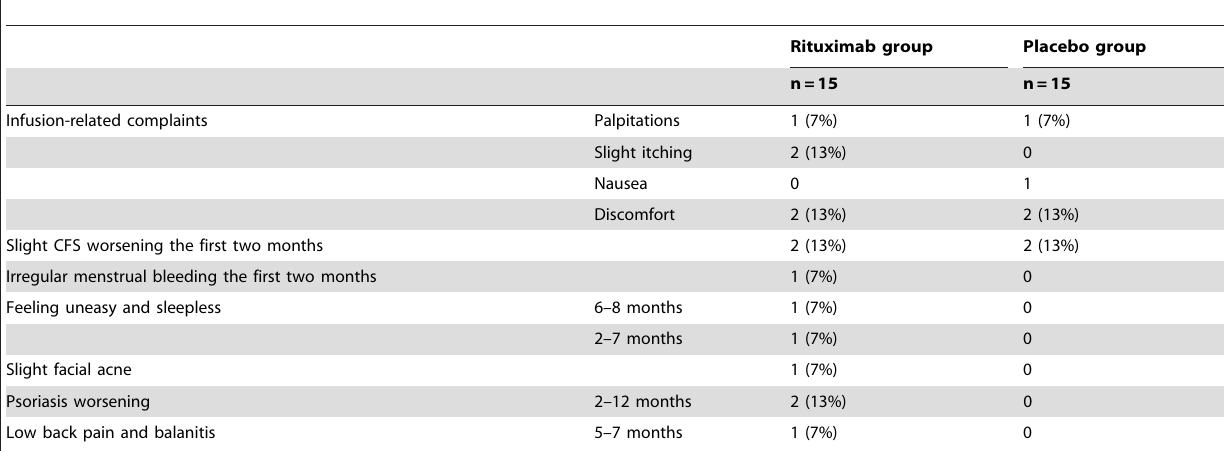
Table 5. Infusion-related complaints during or the first 24 hours after infusion, and side-effects during 12 months follow-up, in the Rituximab and Placebo groups.